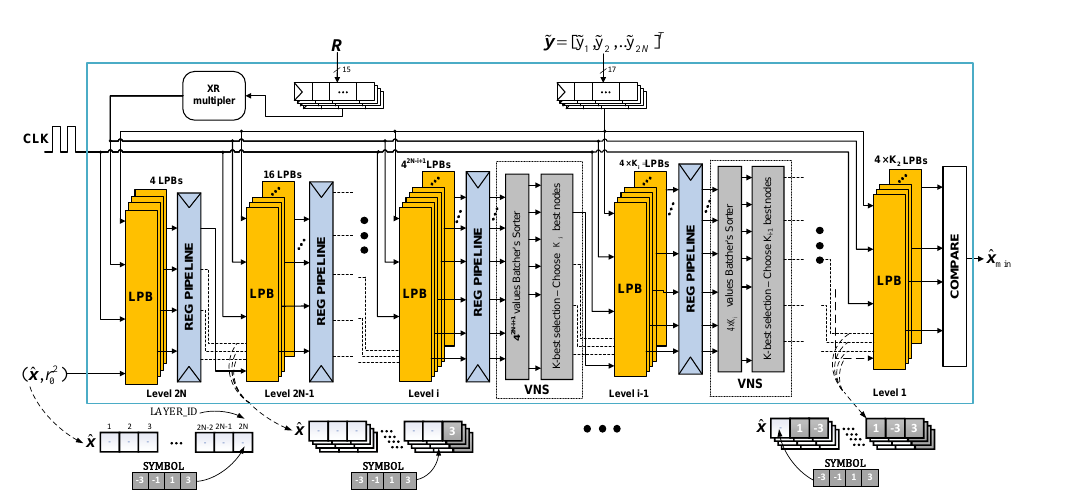
Figure 11. Structure of the hardware implementation of the proposed EHSD.